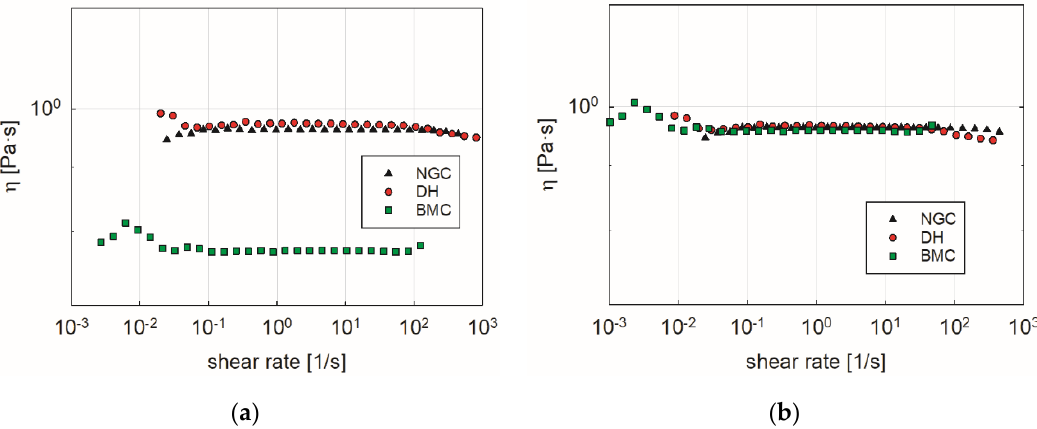
Figure 5. The viscosity of the silicon oil (SO) fluid as a function of shear rate for the NGC and the two complex geometries. ( a ) Results obtained by using the c SS and c SR coefficients provided by Anton Paar; ( b ) Results obtained by using the c SS and c SR coefficients from the Couette analogy.